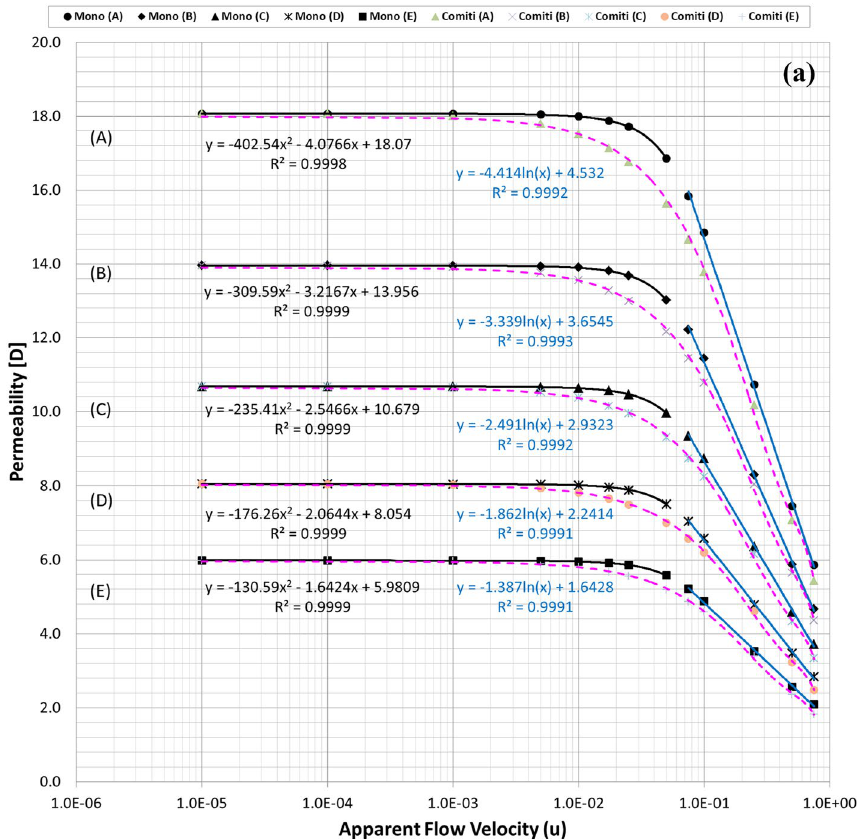
Figure 2. (a) Comparisons of the permeability variations of the mono-size pack models using the modified Comiti equation (dotted pink lines) (Eq. 4b) and those directly obtained from each PSS analysis (solid black and blue lines) relative to the apparent flow velocity increments. (b). Comparisons of the permeability variations of the mono-size pack models using the original Comiti equation (dotted orange lines) based on the pore (hydraulic) diameter presented in Eq. (1) and the data directly obtained from each PSS analysis (solid black and blue lines). (c). Tortuosity variations of the mono-size pack models, estimated using the tortuosity equation (Eq.